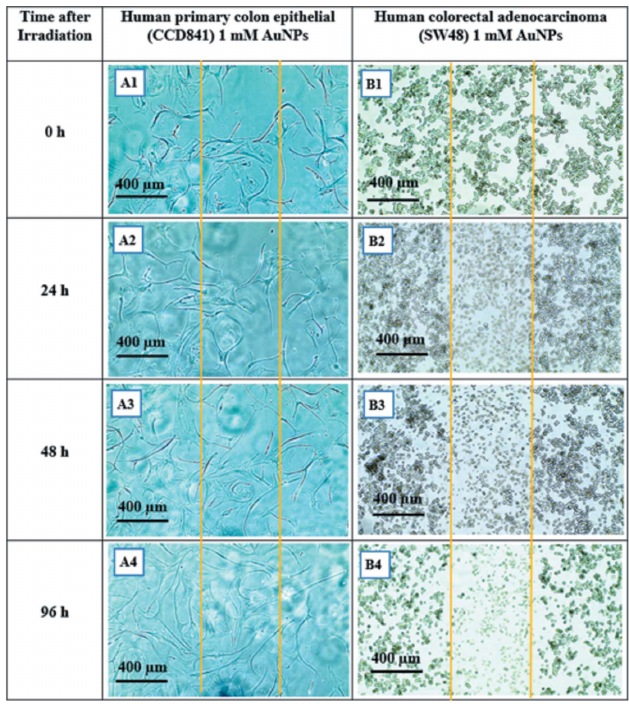
Figure 15 Human primary colon epithelial CCD841 and human colorectal adenocarcinoma SW48 monolayer 24 h after being exposed to 1000 Gy 90 kVp SBB (width 500 m m). Both cell types are treated with 1 m M AuNPs. The radiation fields boundaries are marked with orange lines. (A1) CCD841 immediately after exposure, (A2) 24 h, (A3) 48 h and (A4) 96 h after exposure. (B1) SW48 immediately after exposure, (B1) 24 h, (B2) 48 h and (B4) 96 h after